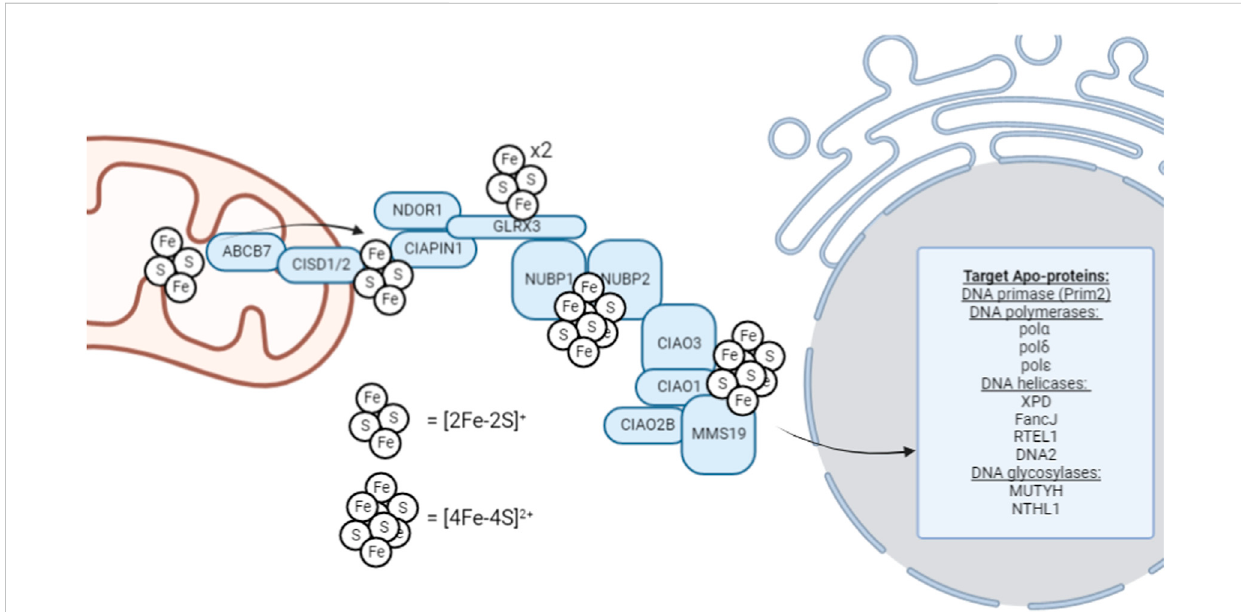
FIGURE 1 Schematic overview of the late-acting, cytosolic iron-sulfur assembly machinery (CIA complex). This schematic represents the general, proposed mechanismof[4Fe-4S] 2+ clustertraf fi ckingthroughtheCIAcomplexforinsertionintocytosolicandnuclear[4Fe-4S] 2+ enzymes;however,notallfactors are required de fi nitively, and theutilization of this pathway can be highly context-dependent. For example, ribonucleotide reductase, critical for S-phase cell cycle entry to begin DNA replication, contains a di-ferric center whose formation is mediated by GLRX3 (Mühlenhoff et al.,